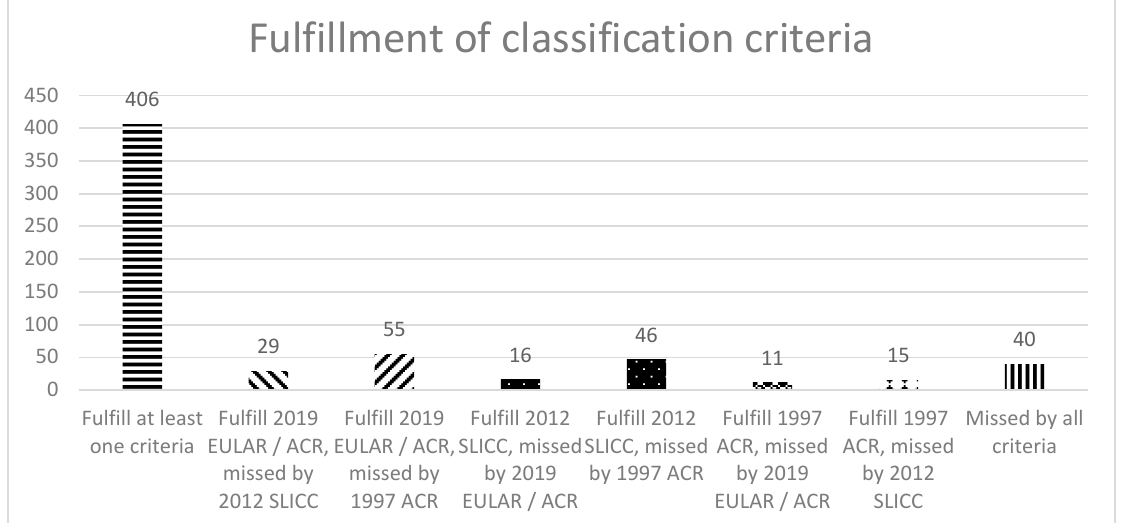
Figure 1. Number of SLE patients who fulfill or are missed by classification criteria. EULAR = European League Against Rheumatism; ACR = American College of Rheumatology; SLICC = Systemic Lupus International Collaborating Clinics.